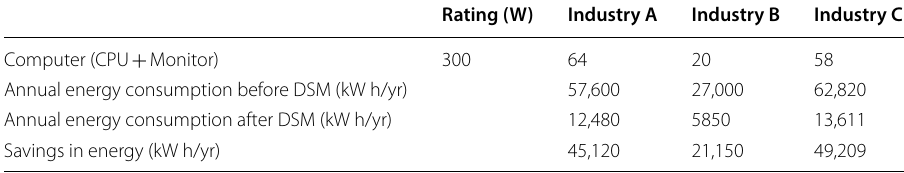
Table 9 Energy consumption in each of the 3 industries before and after DSM solution